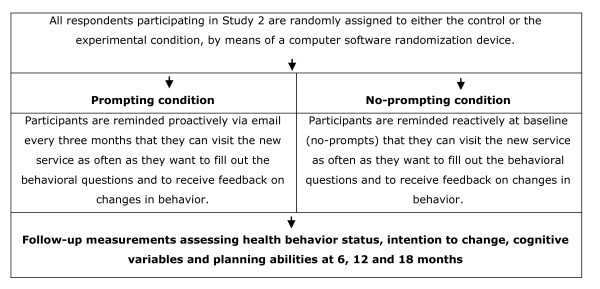
Flowchart study 2.